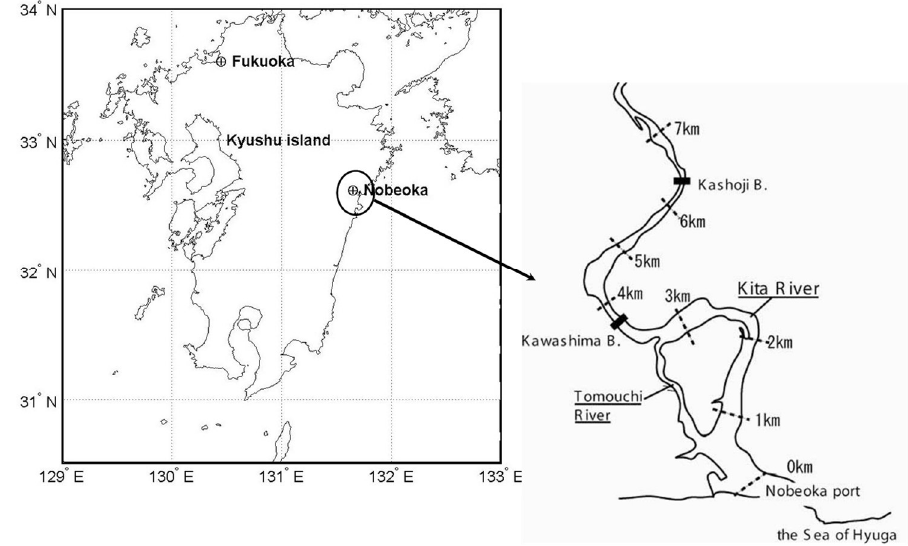
Figure 1. River estuary and sampling stations of D. japonicus .